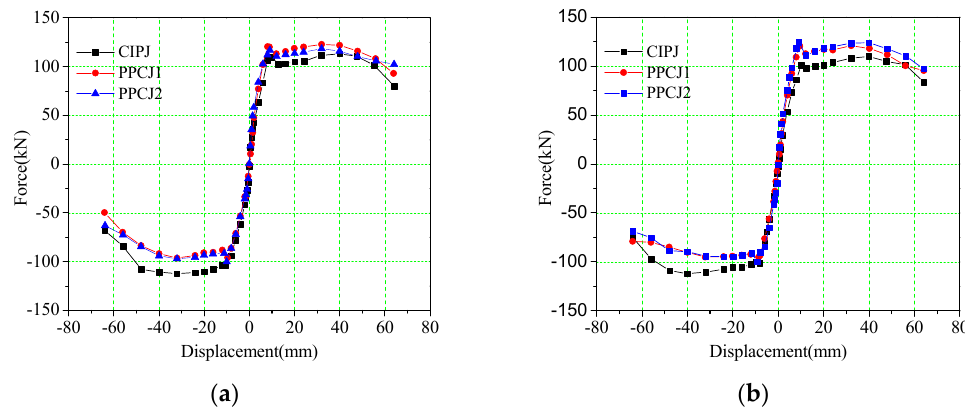
Figure 17. Comparison of joint skeleton curves: ( a ) left beam; ( b ) right beam. Table 3. Parameters of joints from skeleton curves. CIPJ—cast-in-place